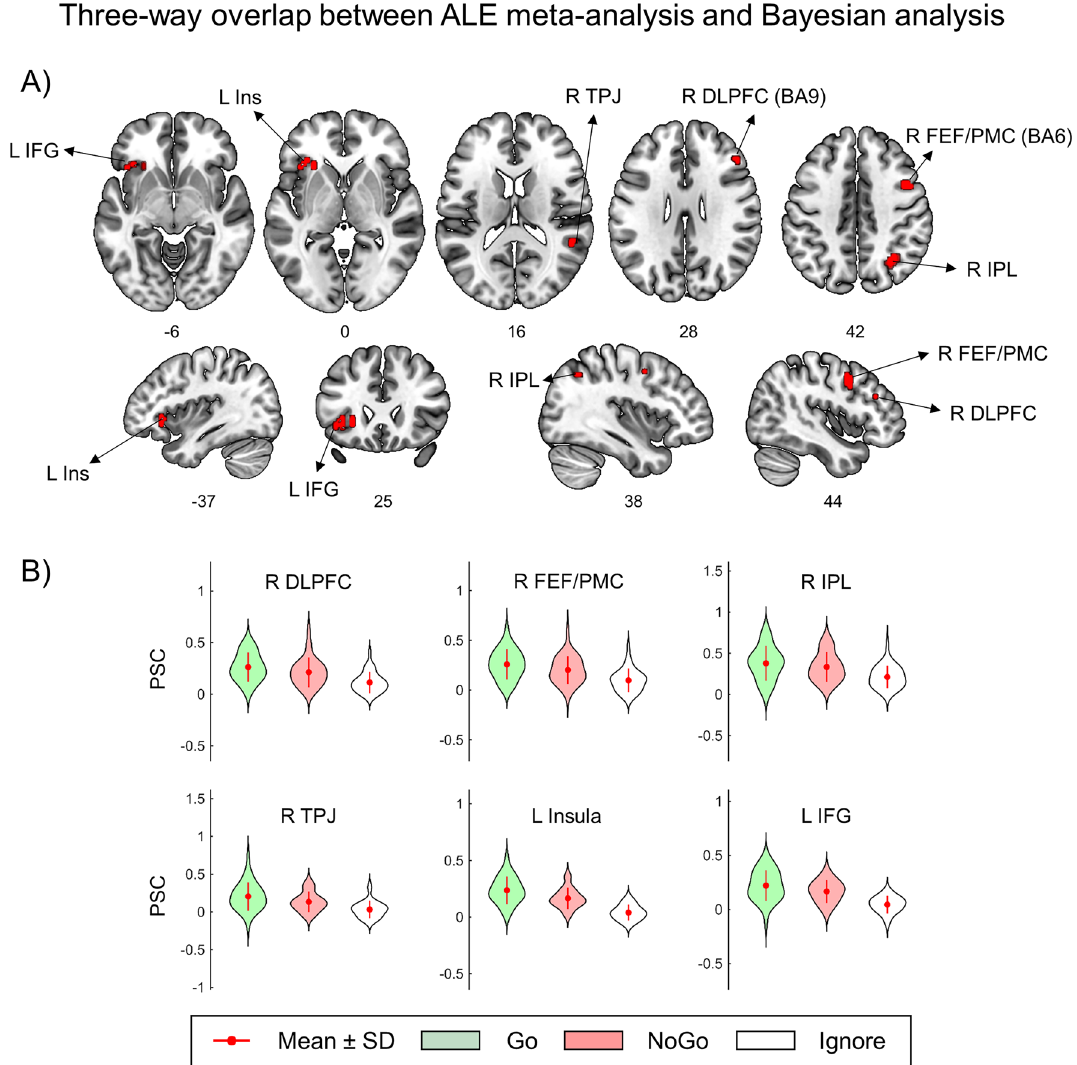
Figure 6. Three-way overlap between the ALE meta-analysis and Bayesian analysis. ( A ) Three-way overlap between (1) inhibitory-related brain areas according to the ALE meta-analysis (“50/50% Go/NoGo blocks > 100% Go-control blocks”), (2) brain areas with practically equivalent neuronal activity in Go and NoGo trials (“NoGo = Go”) and (3) brain areas activated in equiprobable Go and NoGo trials (“Go + NoGo > Ignore”). ( B ) Violin plots of the mean PSC in the revealed clusters. DLPFC dorsolateral prefrontal cortex, FEF frontal eye field, PMC premotor cortex, IPL inferior parietal lobule, TPJ temporoparietal junction, Ins insula, IFG inferior frontal gyrus, BA Brodmann area, L left, R right. Figure was created using MRIcroGL 1.2.2 software (https:// www. nitrc. org/ proje cts/ mricr